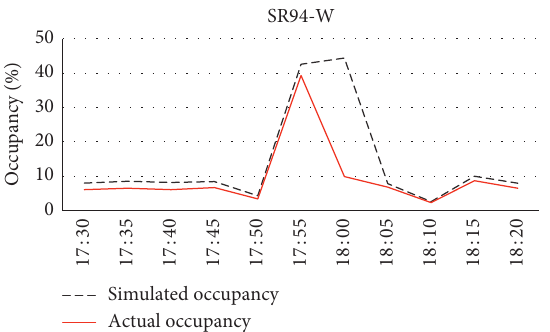
Figure 7: Actual and simulated occupancy comparison at freeway SR94-W.